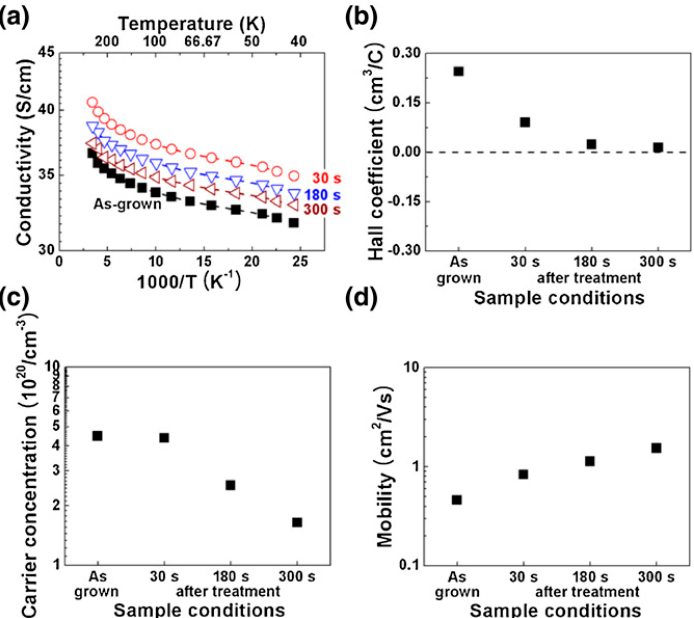
Figure 12. Temperature dependences of ( a ) electrical conductivities, ( b ) Hall coefficients, ( c ) carrier densities, and ( d ) carrier mobilities of the CNWs before and after post-growth N 2 gas plasma treatments. Reproduced with permission from [130]. Copyright The Japan Society of Applied Physics 2014.